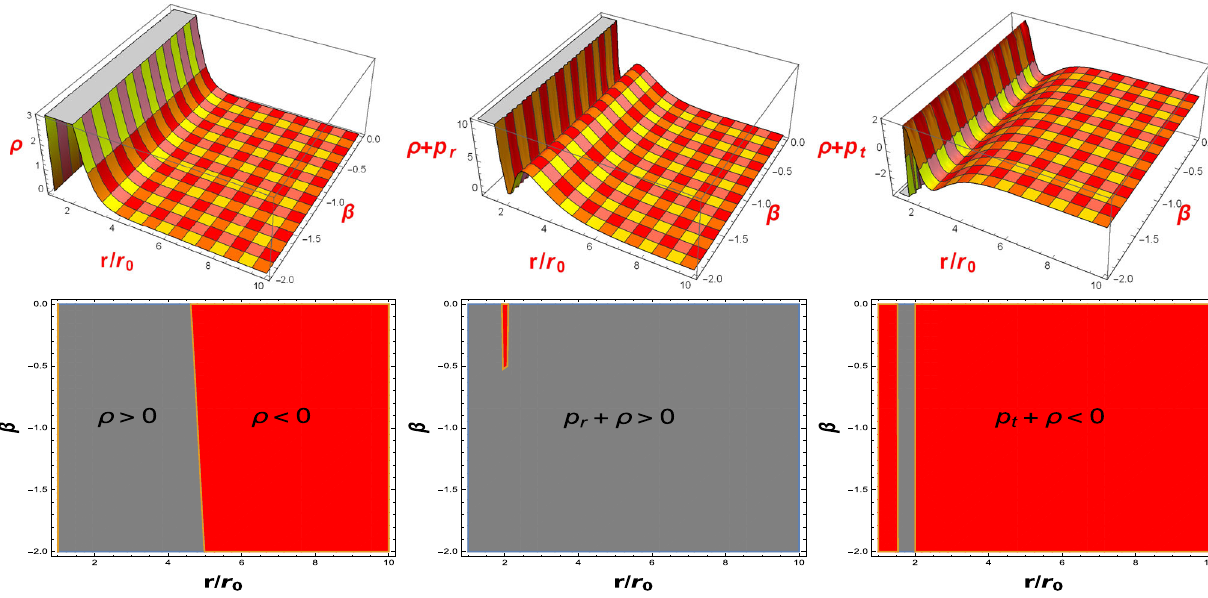
Fig. 4 Exponential shape function